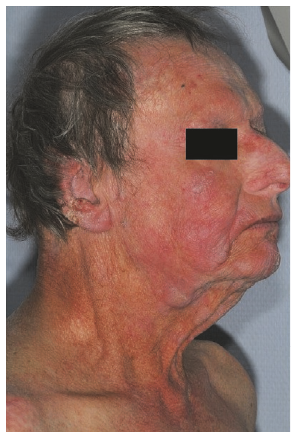
Figure 2: Exophytic lesion of the nose before radiotherapy (side view).